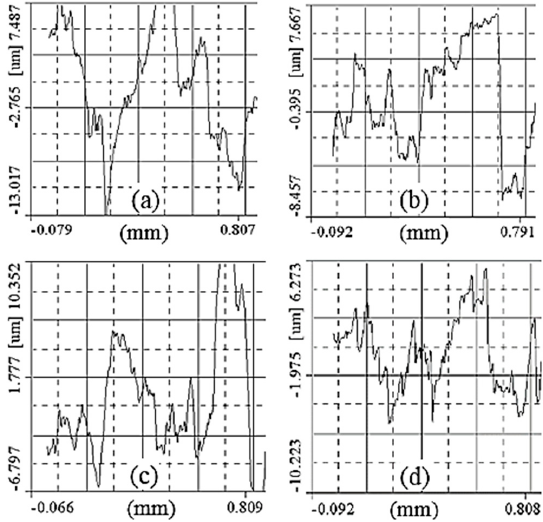
Figure 2. Surface profile of machined surface at: ( a ) 60 mm/min speed, 0.025 mm/tooth feed; ( b ) 60 mm/min speed, 0.075 mm/tooth feed; ( c ) 140 mm/min speed, 0.025 mm/tooth feed and ( d ) 140 mm/min speed, 0.075 mm/tooth feed.